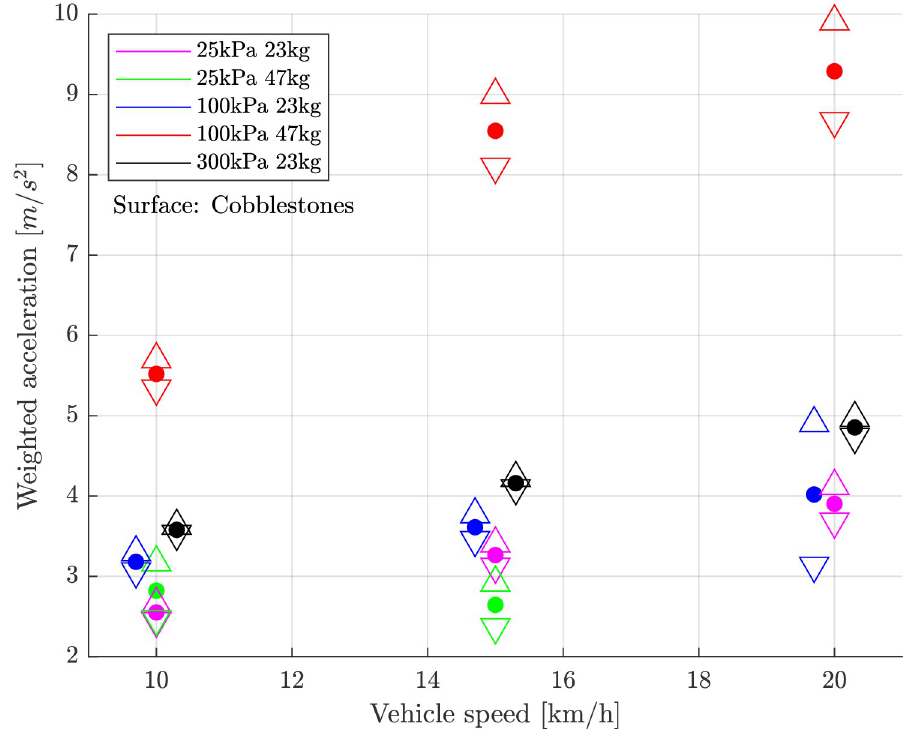
Fig 5. Child carrier: Weighted vibration level over vehicle speed on cobblestones surface. 4 and 5 indicate the 95% confidence interval. Black and blue values have been moved laterally by a few mm for better visibility.